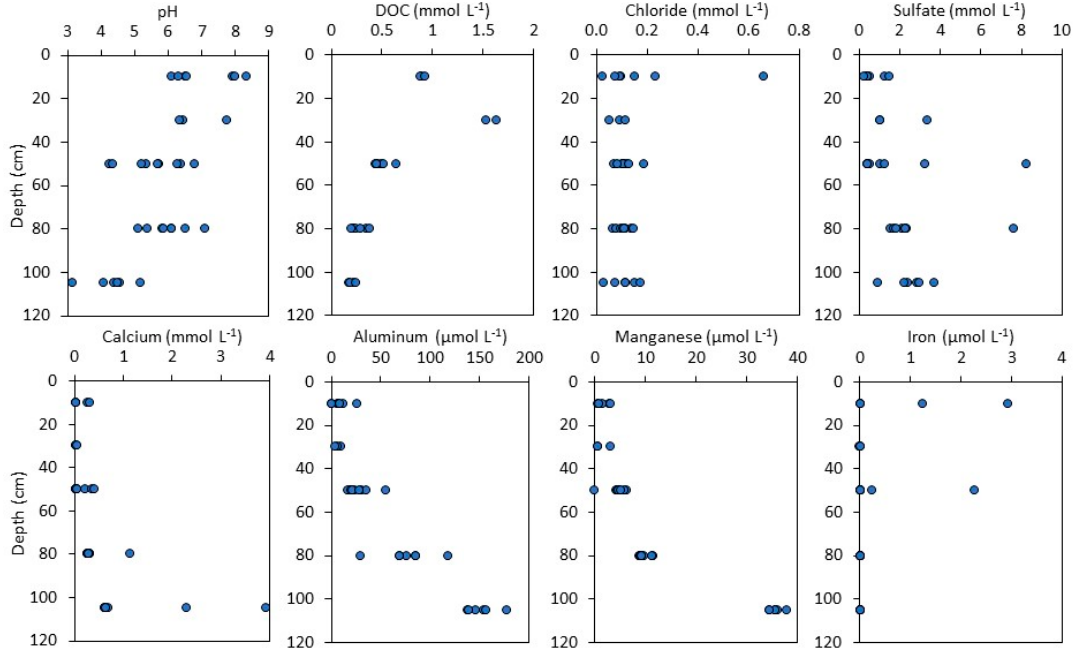
Figure 6. pH and solute concentrations (either mmol L − 1 or µmol L − 1 ) in soil water collected from suction lysimeters installed in the spoil pile. Each point represents an individual sample or